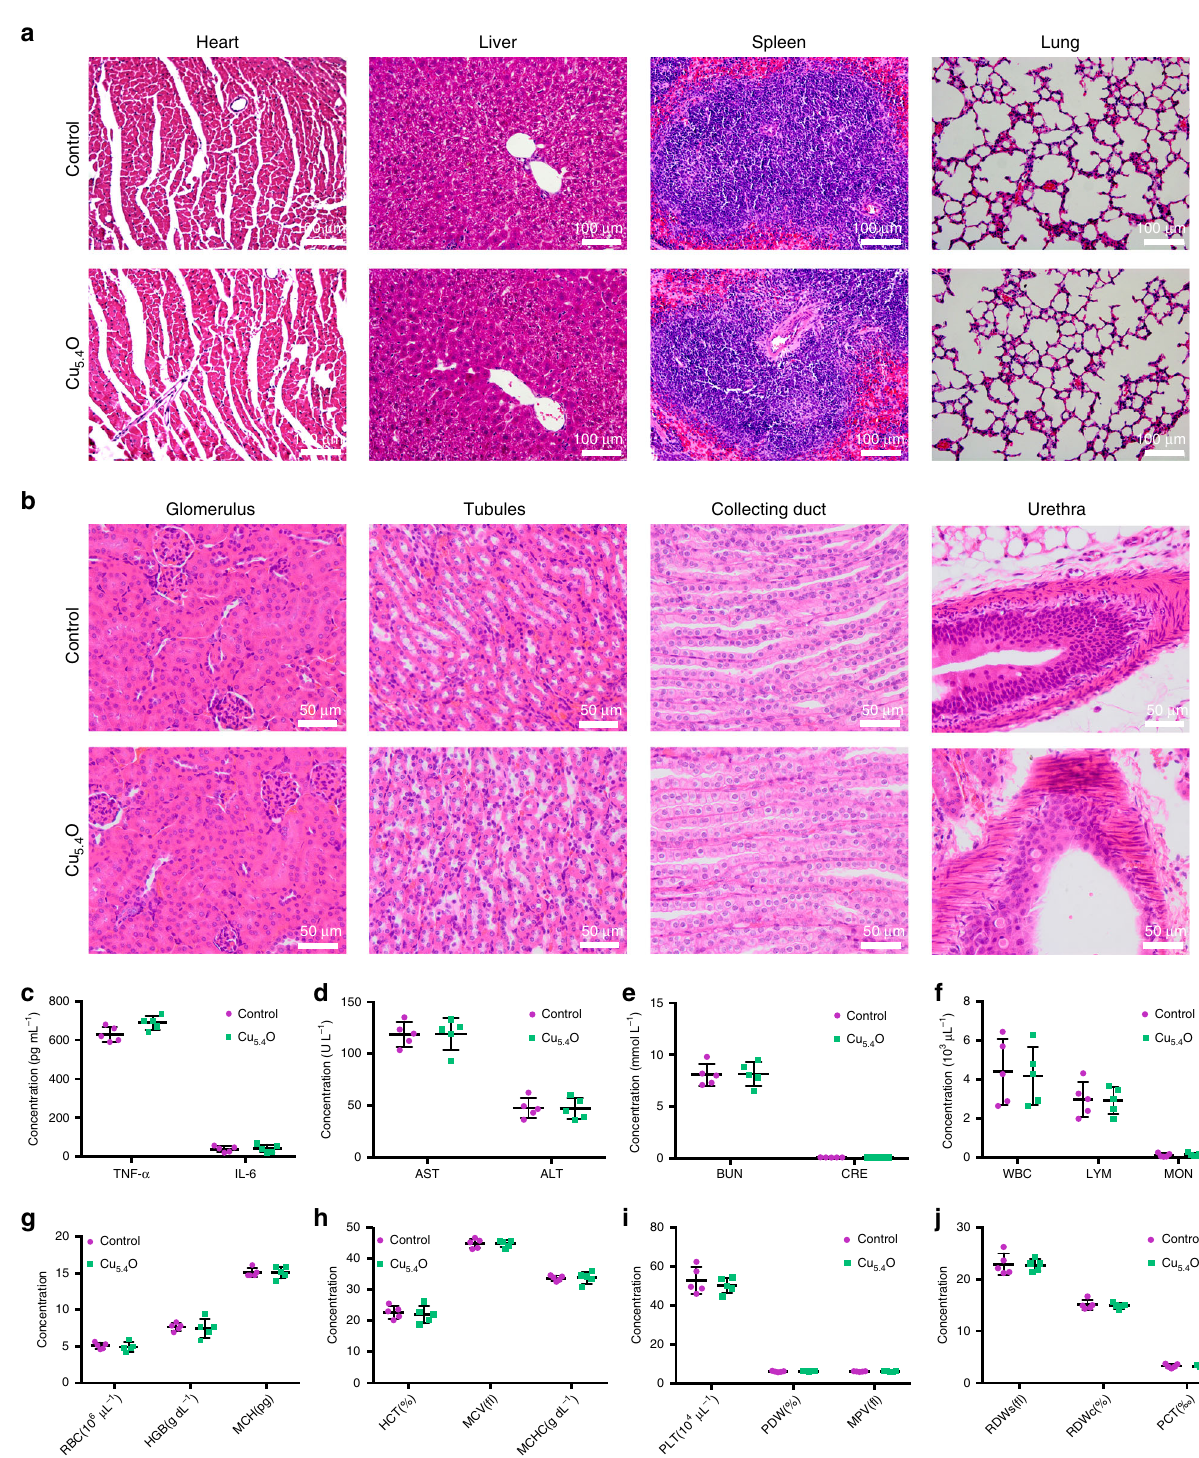
Fig. 5 In vivo biocompatibility assessment of Cu 5.4 O USNPs. a Evaluation of in vivo toxicity of Cu 5.4 O USNPs to major organs (heart, liver, spleen, and lung) at 24 h after intravenous administration. b Assessment of in vivo toxicity of Cu 5.4 O USNPs to the kidney at 24 h after intravenous administration. c Serum levels of in fl ammatory factors of interleukin-6 (IL-6) and tumor necrosis factor alpha (TNF- α ). d Serum levels of liver function indicators: aspartate transaminase (AST) and alanine transaminase (ALT). e Serum levels of kidney function indicators: blood urea nitrogen (BUN) and creatinine (CRE). f – j Blood parameters in normal mice (control group), and mice intravenously injected with Cu 5.4 O USNPs, 24 h after injection. In c – j , data represent means ± s.d. from fi ve independent replicates. Source data are provided as a Source Data fi